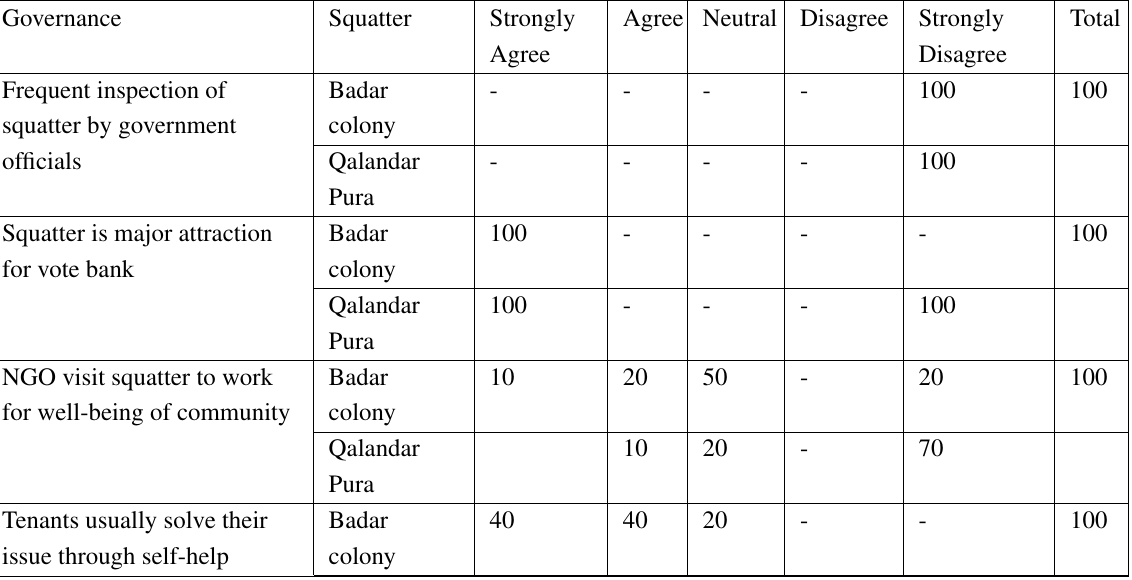
Table 5. Governance issues of squatters, Source: